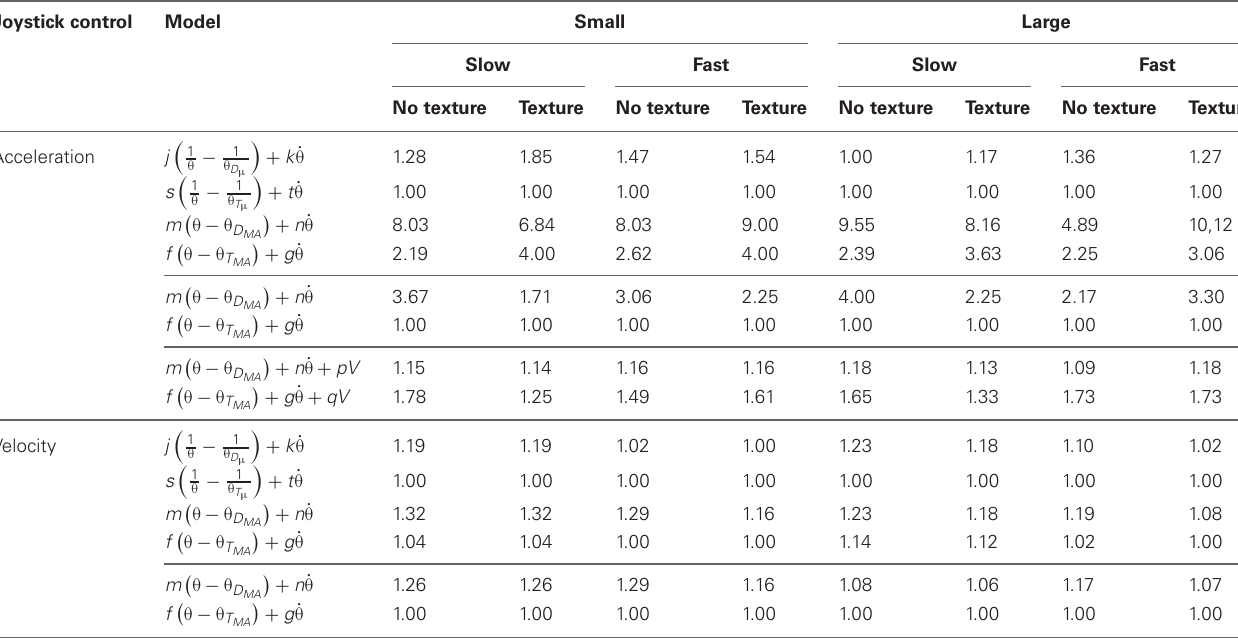
Table 4 | Bayes Factor scores ( B ) for the θ D μ , θ T μ , θ D function of the size of the lead object, its speed, and the presence of ground texture. Joystick